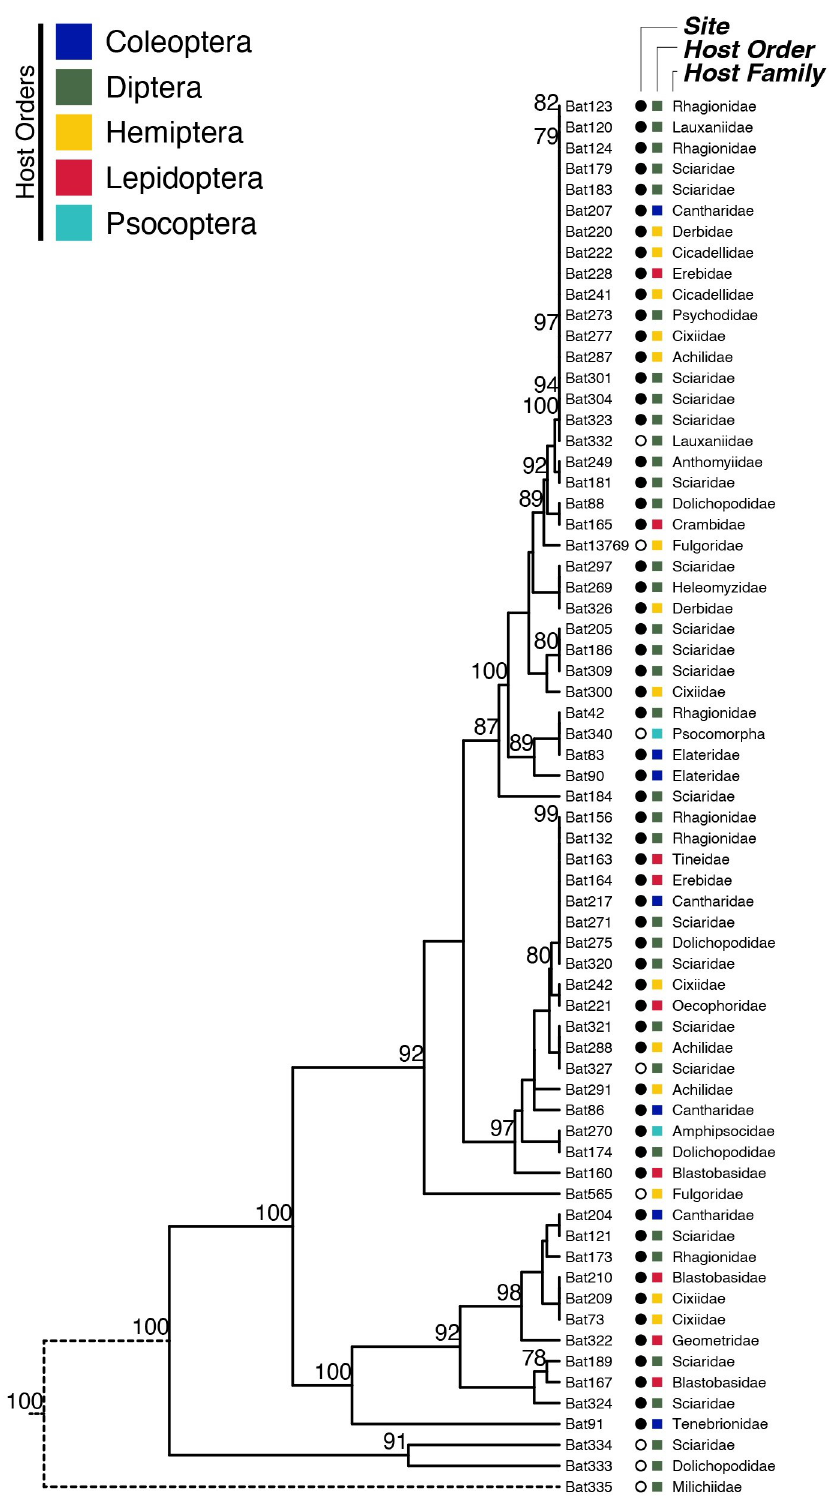
Fig 3. Dendrogram of all B . major isolates. Each specimen is labelled according to the order and family of the arthropod host from which it was sampled. Population origin is also specified, with an open circle for the Angora Fruit Farm population and a closed circle for the Danby State Forest population. Nodes whose bootstrap support was greater